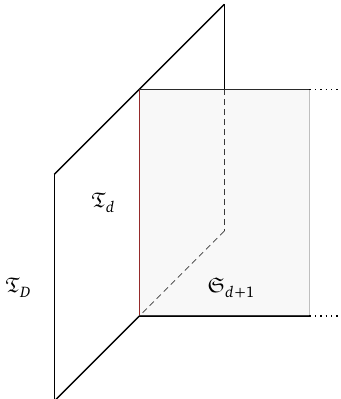
Figure 8: Relative defect T